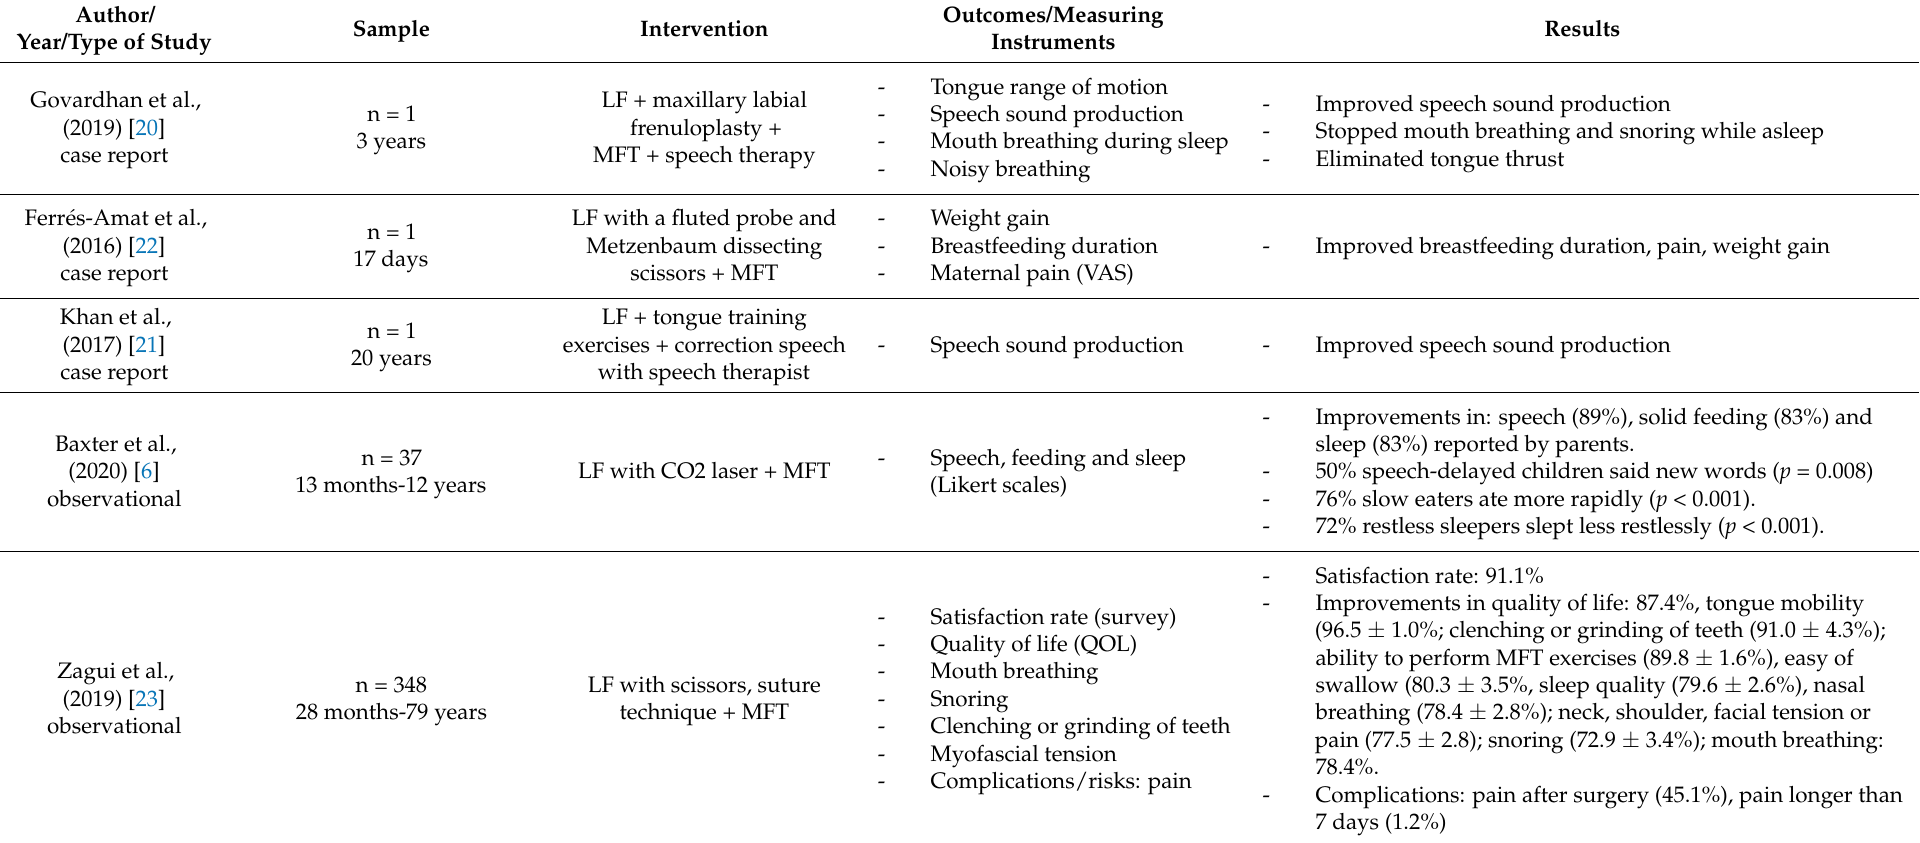
Table 2. Characteristics of the Study